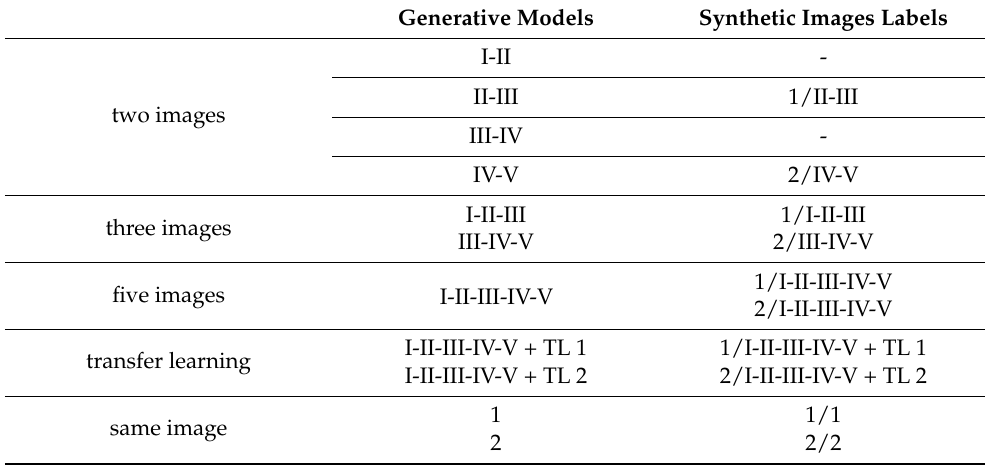
Table 4. Generative models and synthetic images used to evaluate the models